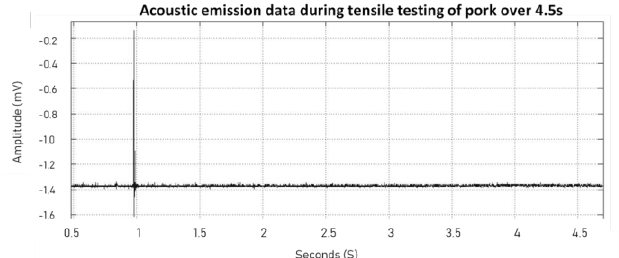
Figure 9. Zoomed in display of amplitude against time (s) for tensile test on pork specimen. This illustrates the absence of any sound which may be associated with deformation of the specimen.